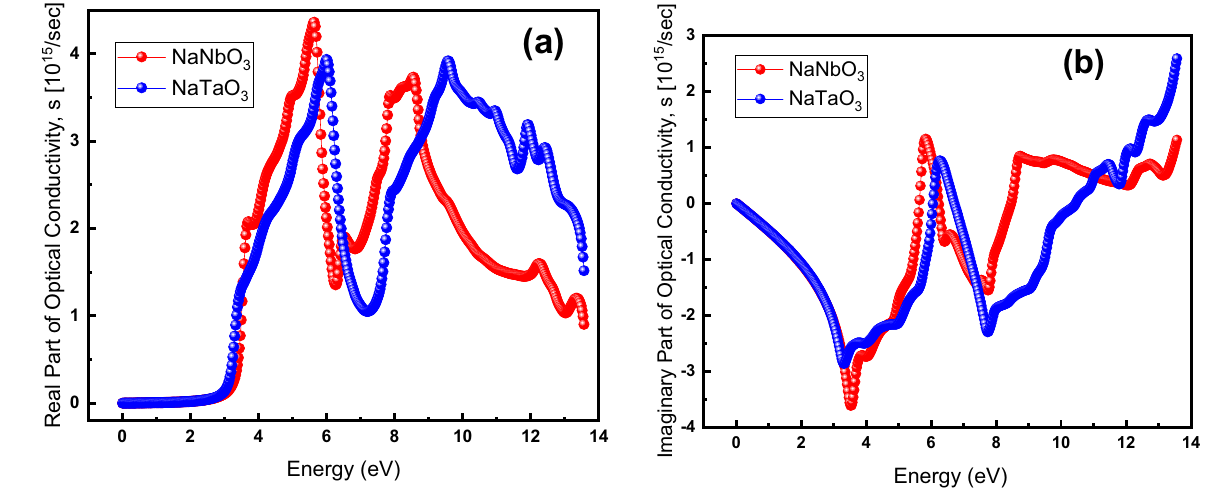
Figure 8. (Color Online) ( a ) real and ( b ) imaginary parts of optical conductivity for NaNbO 3 (red) and NaTaO 3 oxide perovskites.